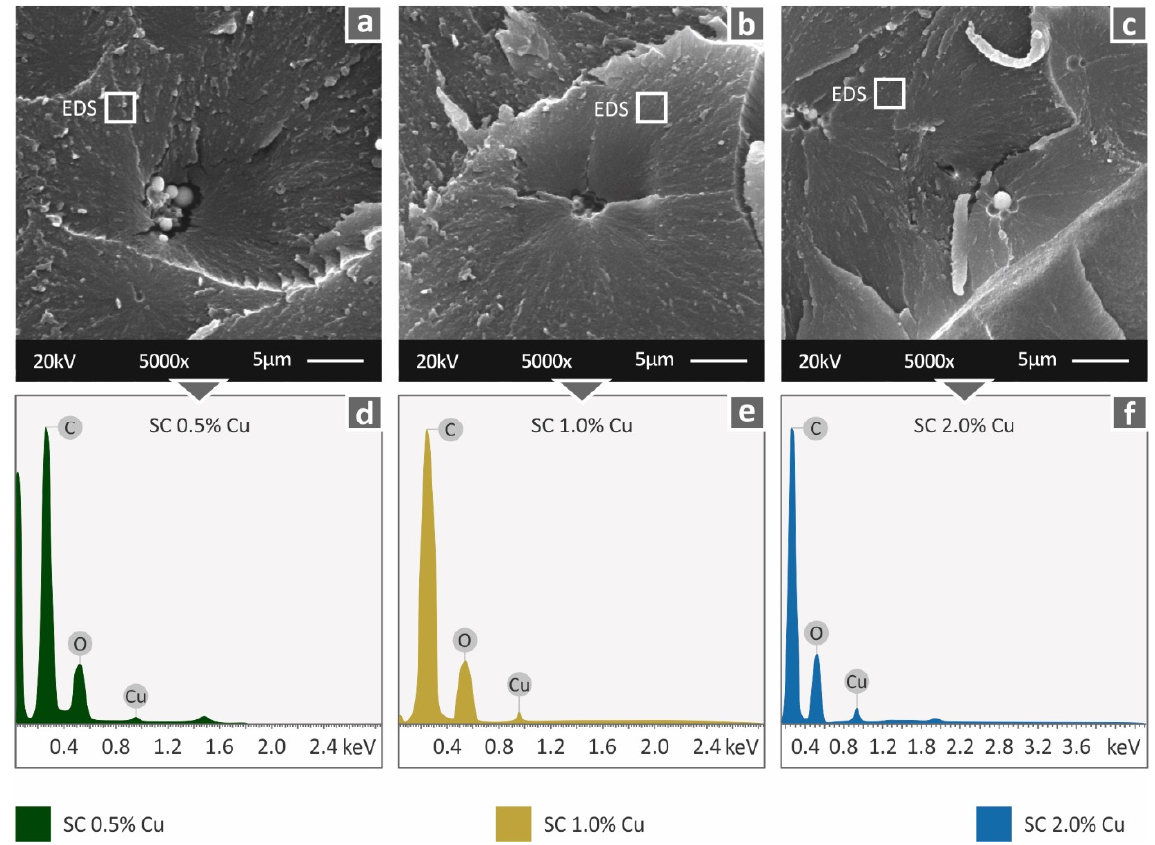
Figure 10. Fracture area high magnification captures at 5000× level ( a ) SC Cu 0.5 wt.%, ( b ) SC Cu 1.0 wt.%, ( c ) SC Cu 2.0 wt.% and the corresponding EDS analysis results ( d ) SC Cu 0.5 wt.%, ( e ) SC Cu 1.0 wt.%, ( f ) SC Cu 2.0 wt.%. White squares indicate the areas for EDS analysis.